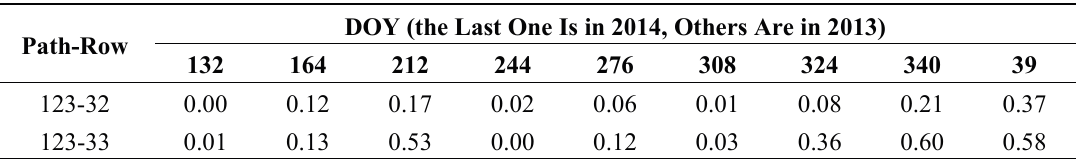
Table 1. Cloud cover proportions (range from 0 to 1) for Landsat 8 images used in this research. DOY (the Last One Is in 2014, Others Are in 2013) Path-Row